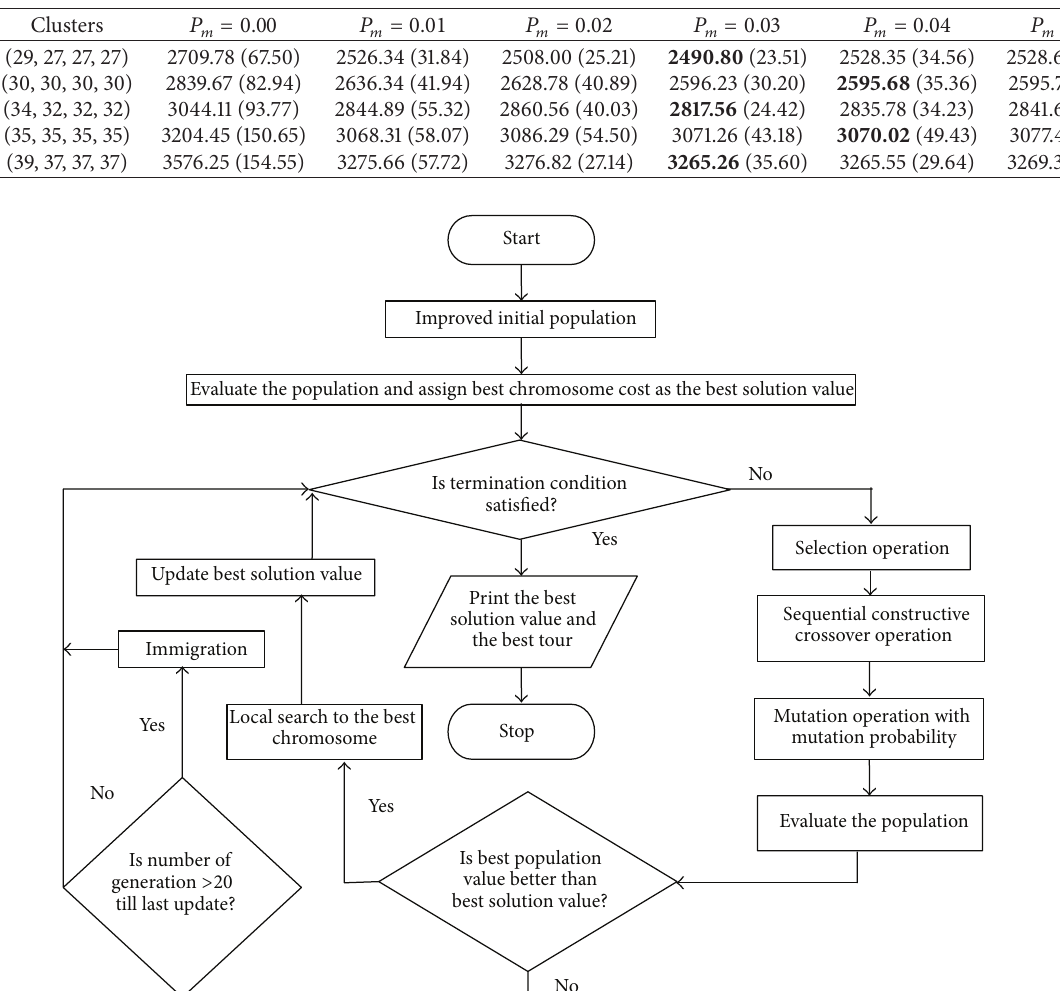
Figure 4: Flowchart of our hybrid genetic